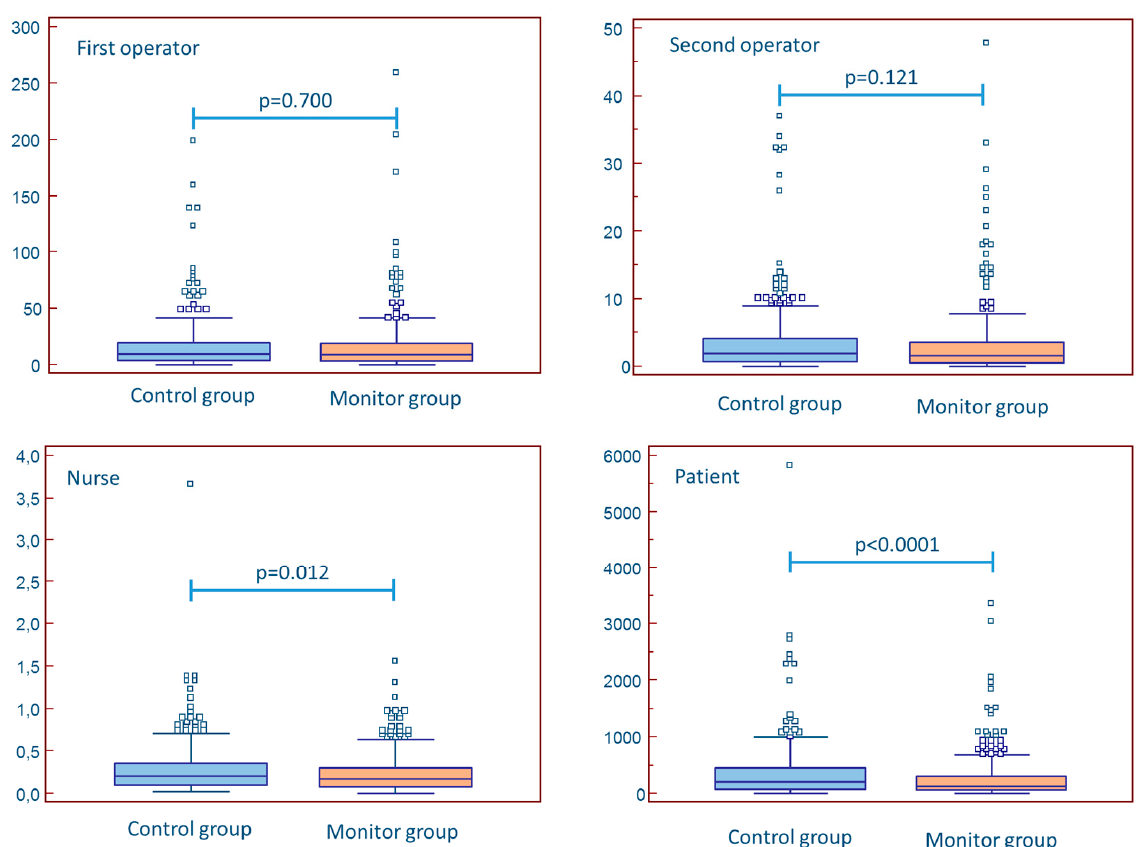
Figure 2. The impact of real-time monitoring on operator, nurse, and patient exposure. Table 2. The impact of real-time dosimetry monitoring.